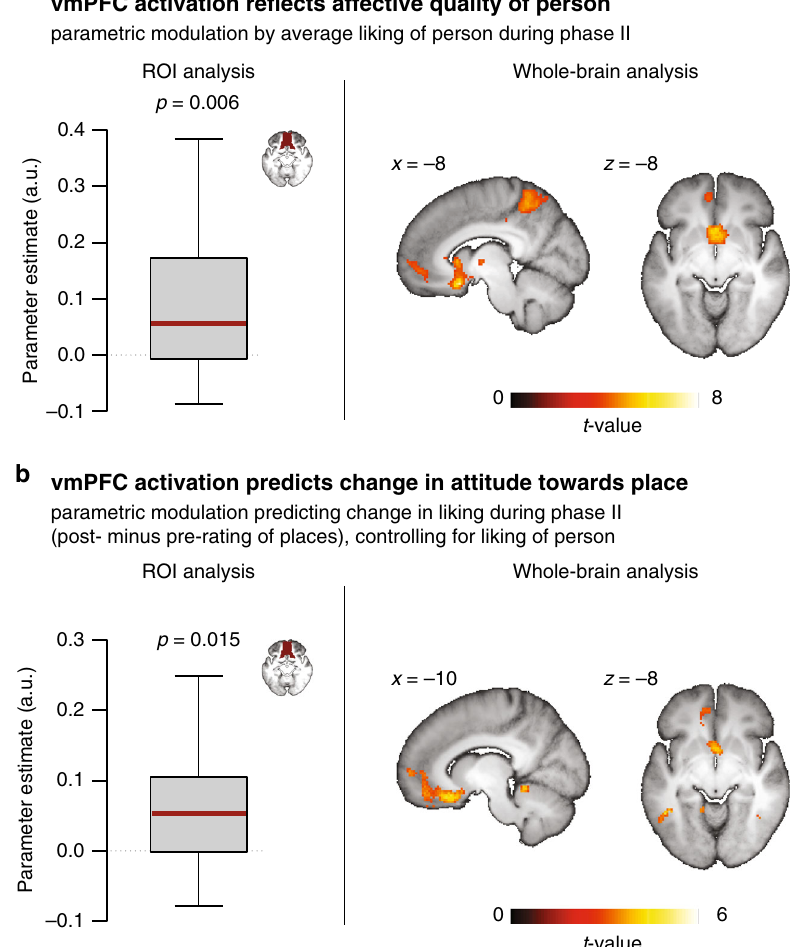
Fig. 4 Transfer of affective value from the UCS to the CS during integrative simulations. a BOLD signal in the vmPFC was modulated by the liking of the UCS (i.e., the person), re fl ecting the contribution of its affective value to the simulation. (For display purposed, exploratory whole-brain maps are thresholded at p < 0.001, uncorrected with a cluster extend of at least 15 voxels.) b Even controlling for ( a ), BOLD signal in the vmPFC further predicted the ensuing change in liking of the CS, thus indicating a transfer of affective value (from the liked UCS to their paired CS). (For display purposes, exploratory whole-brain maps are thresholded at p < 0.005, uncorrected with a cluster extend of at least 15 voxels.) Boxplots indicate the median, central quartiles, and + / − 2.7 SD. a.u., arbitrary